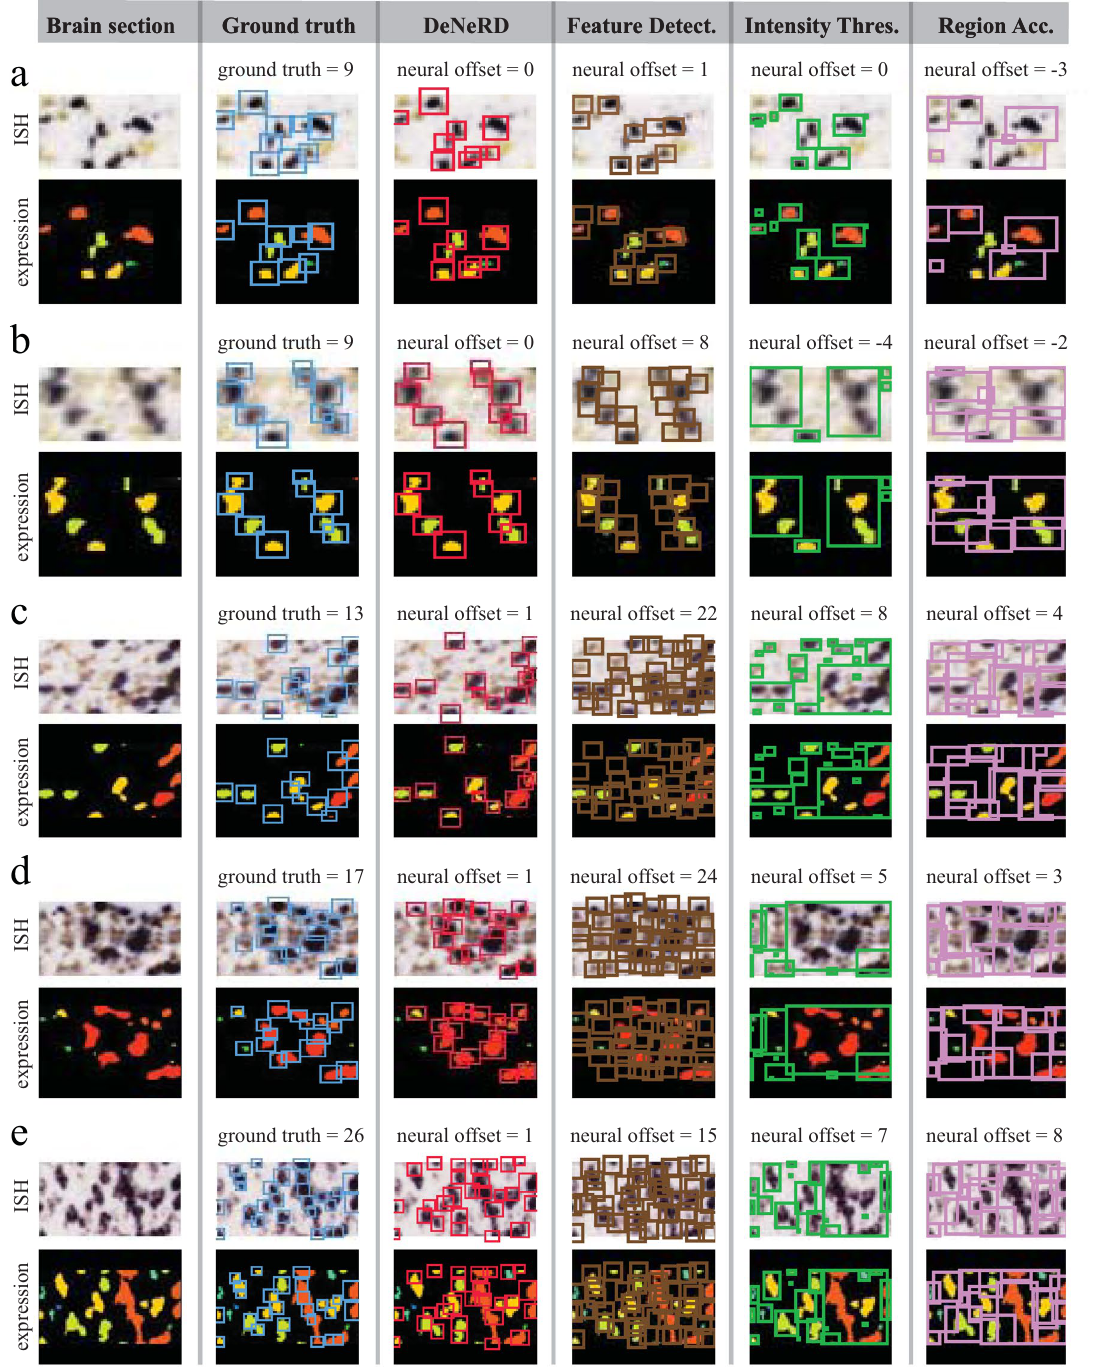
Figure 6. Performance comparison of DeNeRD with other commonly used neuron detection techniques. DeNeRD outperforms these methods in almost all the examples. For cases with < 10 number of neurons in a given image ( a , b ), the other three methods show relatively low neural offset ( ground _ truth – prediction ) score, but in examples containing > 10 number of neurons ( c – e ), their neural offset score is increasingly high. Column 1 shows five cropped example images from brain sections with increasing neural density and complexity from top to bottom (mRNA in - situ hybridized with their expression images below each one). Column 2 shows the ground-truth (human annotated) bounding boxes (blue) on top of the neurons in brain images in column 1 with the number of neurons. Performance of DeNeRD in neuron detection on the given images in column 1 is shown in column 3 with red bounding boxes on top of the neuron detection along with the neural offset at the top. Performance of feature detection-based method is shown with neuron detection (brown bounding boxes) and neural offsets in column 4. Intensity thresholding-based method’s predictions are shown for neuron detection (green bounding boxes) along with the neural offsets in column 5. Region accumulation-based (watershed) algorithm is shown with the performance for neuron detection in pink bounding boxes with neural offsets in column